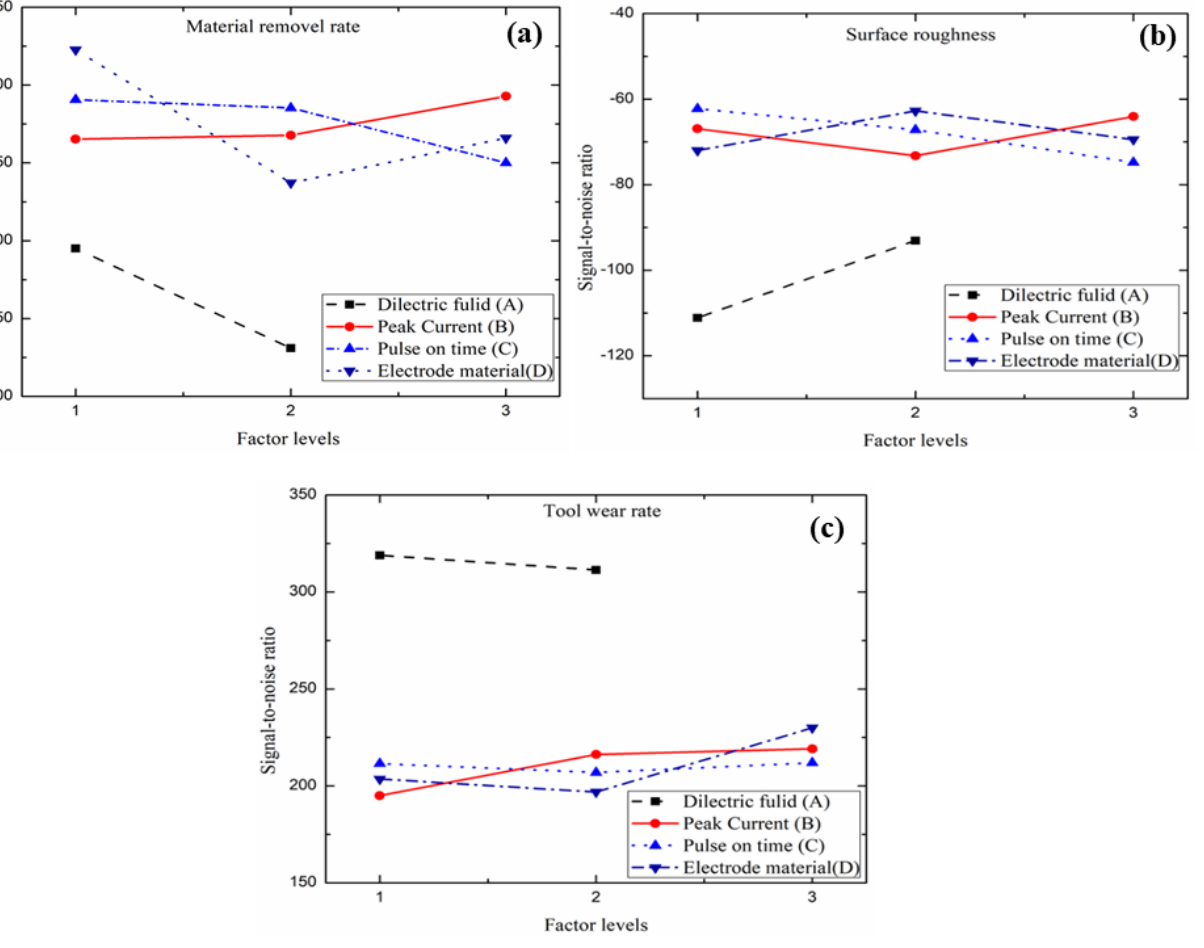
Figure 4. Main effect plots for outputs: ( a ) MRR, ( b ) SR, and ( c ) TWR. Table 8. Pareto ANOVA results for material removal rate